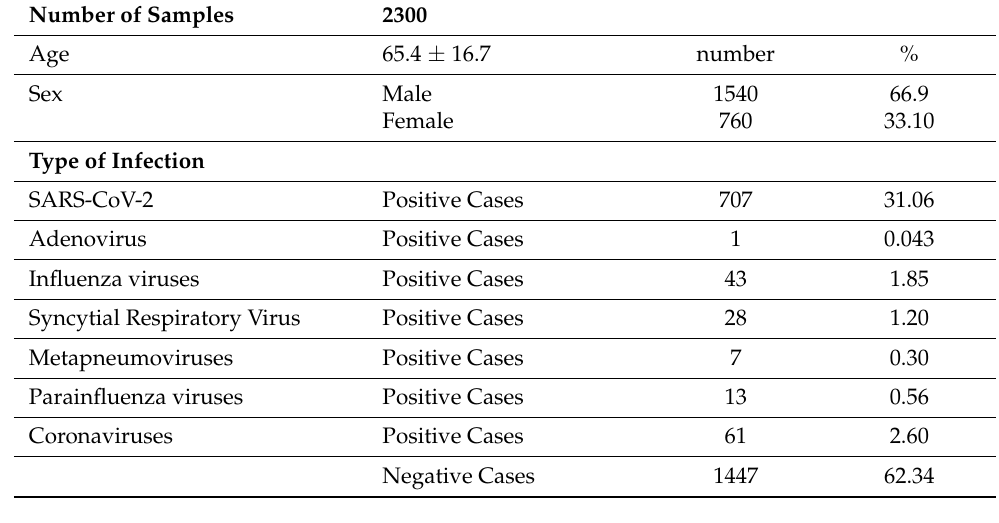
Table 2. Patient cohort analyzed from October 2019 to November 2021 and FilmArray Respiratory Panel 2.1 plus assay results.